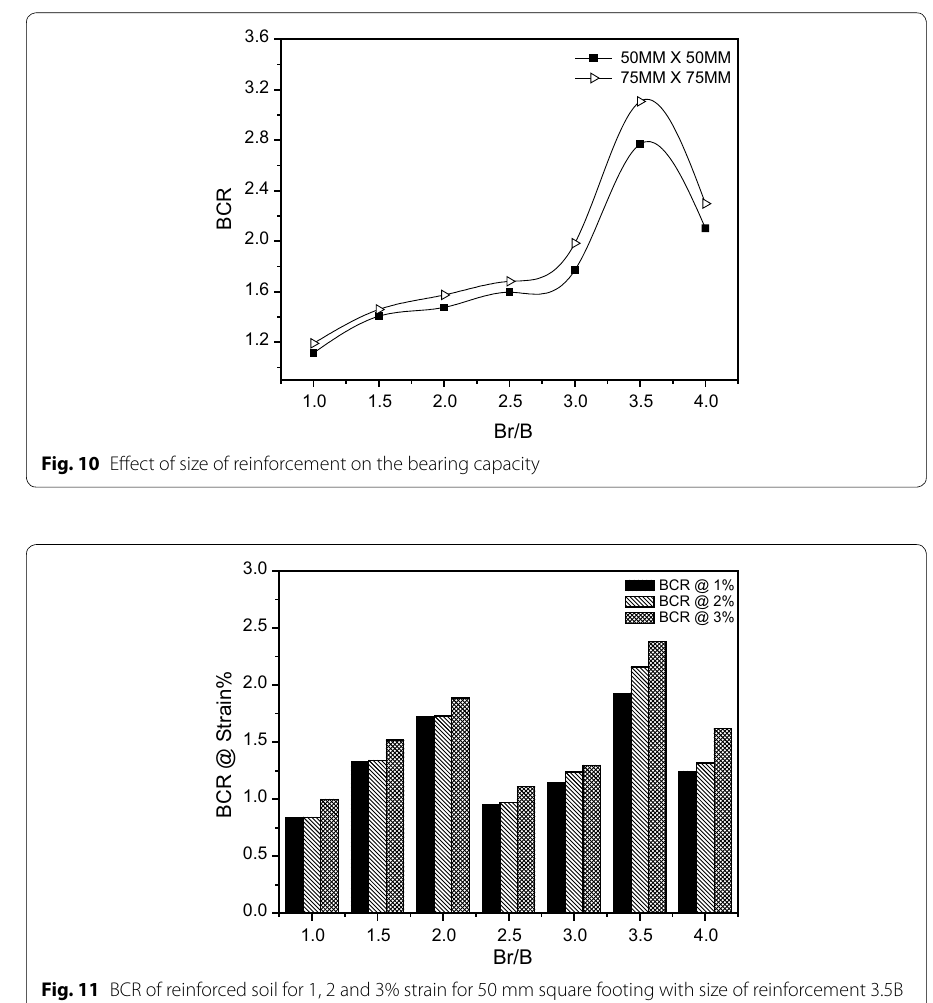
Fig. 11 BCR of reinforced soil for 1, 2 and 3% strain for 50 mm square footing with size of reinforcement 3.5B